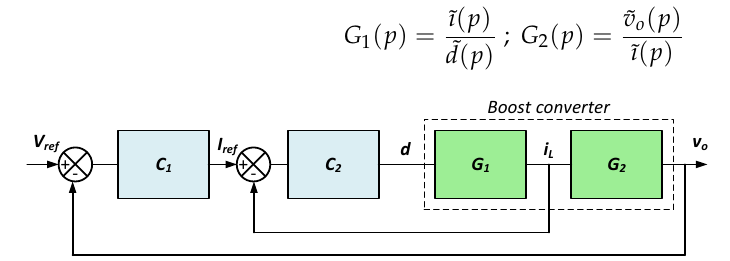
Figure 7. Cascade PI–PI control of the boost